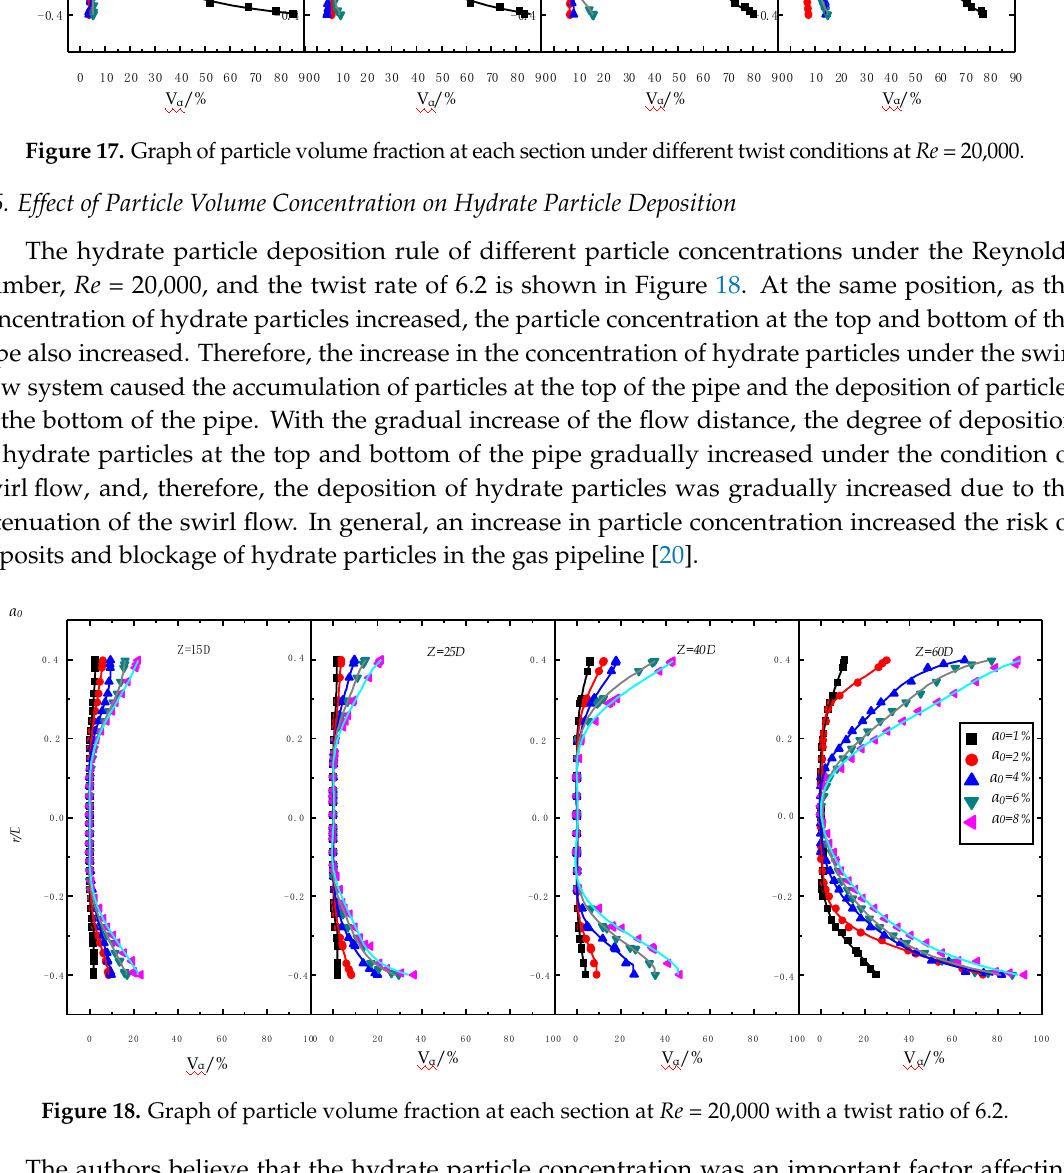
Figure 17. Graph of particle volume fraction at each section under different twist conditions at Re = 20,000.